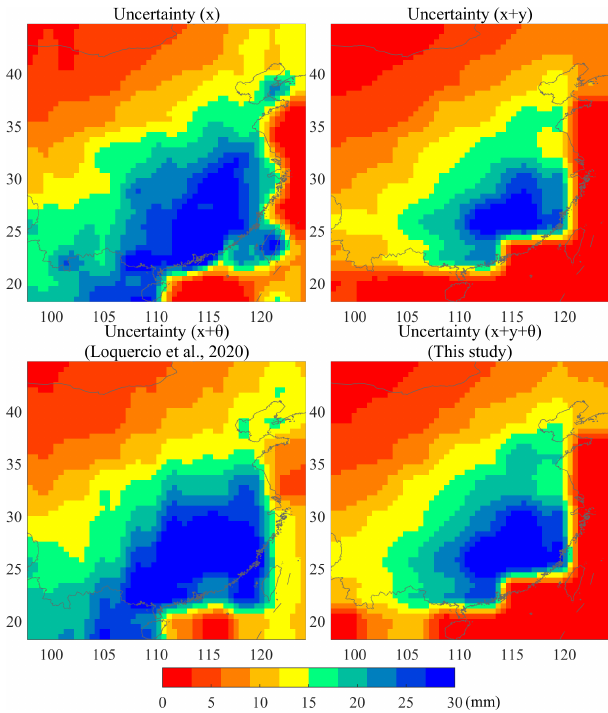
Figure 8. The spatial patterns of uncertainty for precipitation fore- casting.